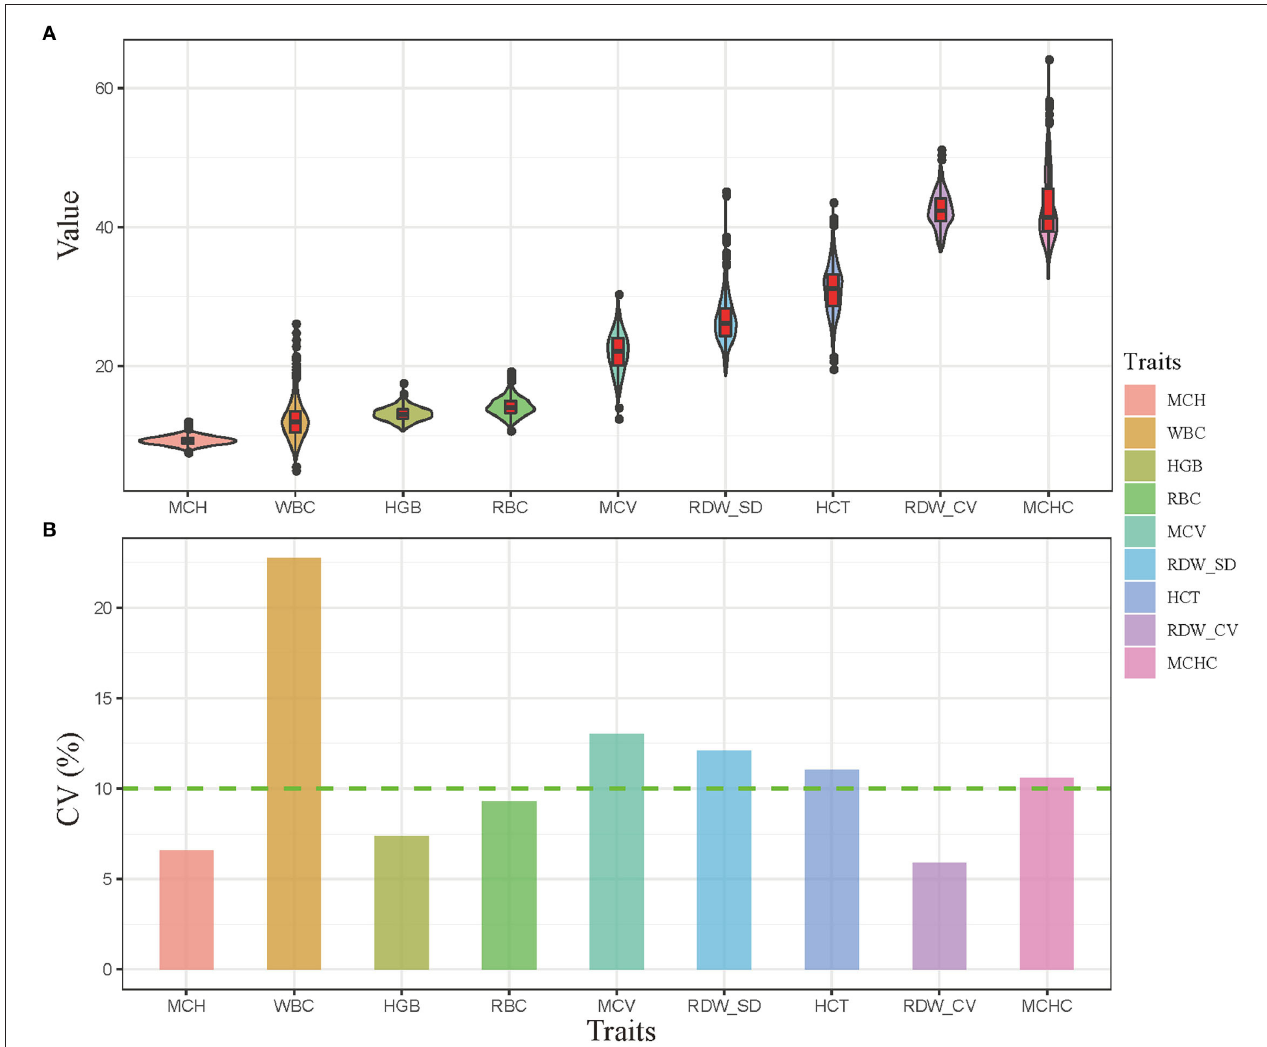
FIGURE 2 | Descriptive statistics for hematologic parameters. (A) The violin plot of hematologic indexes. (B) The coefficient of variation of hematologic